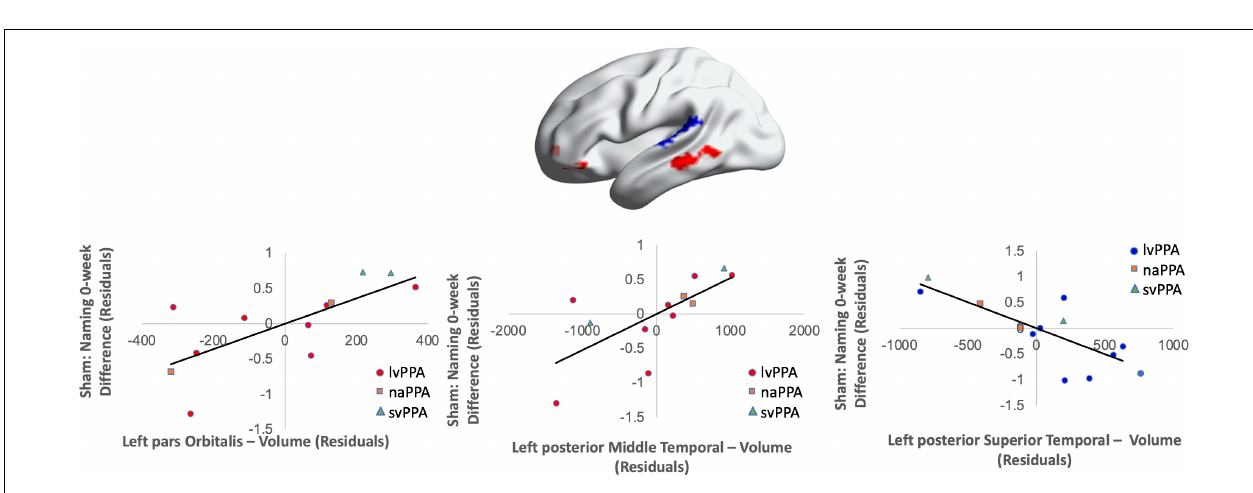
FIGURE 7 | Greater baseline cortical thickness of the IFGorb (highlighted in red), MTG (highlighted in red), and lower thickness of the pSTG (highlighted in blue) predicted sham naming gains at 0-week post-intervention (red = greater thickness; blue = lower thickness; R 2 =